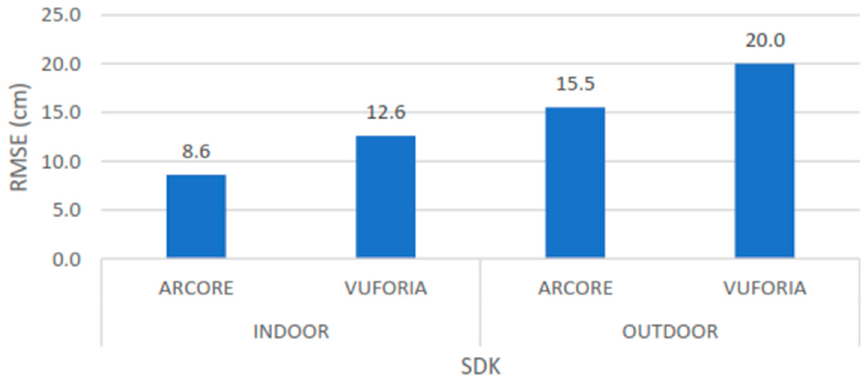
Figure 16. Comparison between Vuforia and